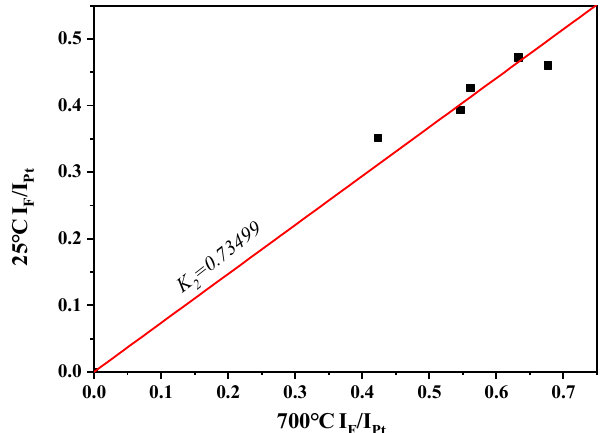
Figure 8. Relationship between the accumulation intensity ratio I CF /I Pt of the diffraction peak at room temperature and 700 °C.